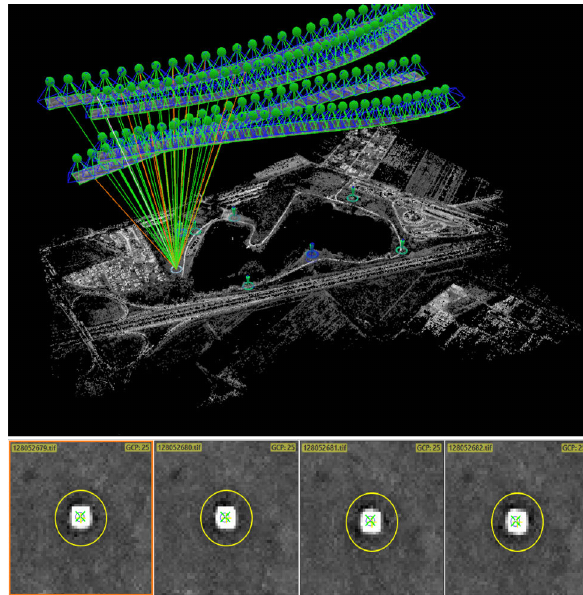
Figure 8. Coastal blue image bundle block; top: 3D-view of automatically matched image tie points, image rays intersecting at manually measured control point 25; bottom: control point 25 displayed in images 52679-82